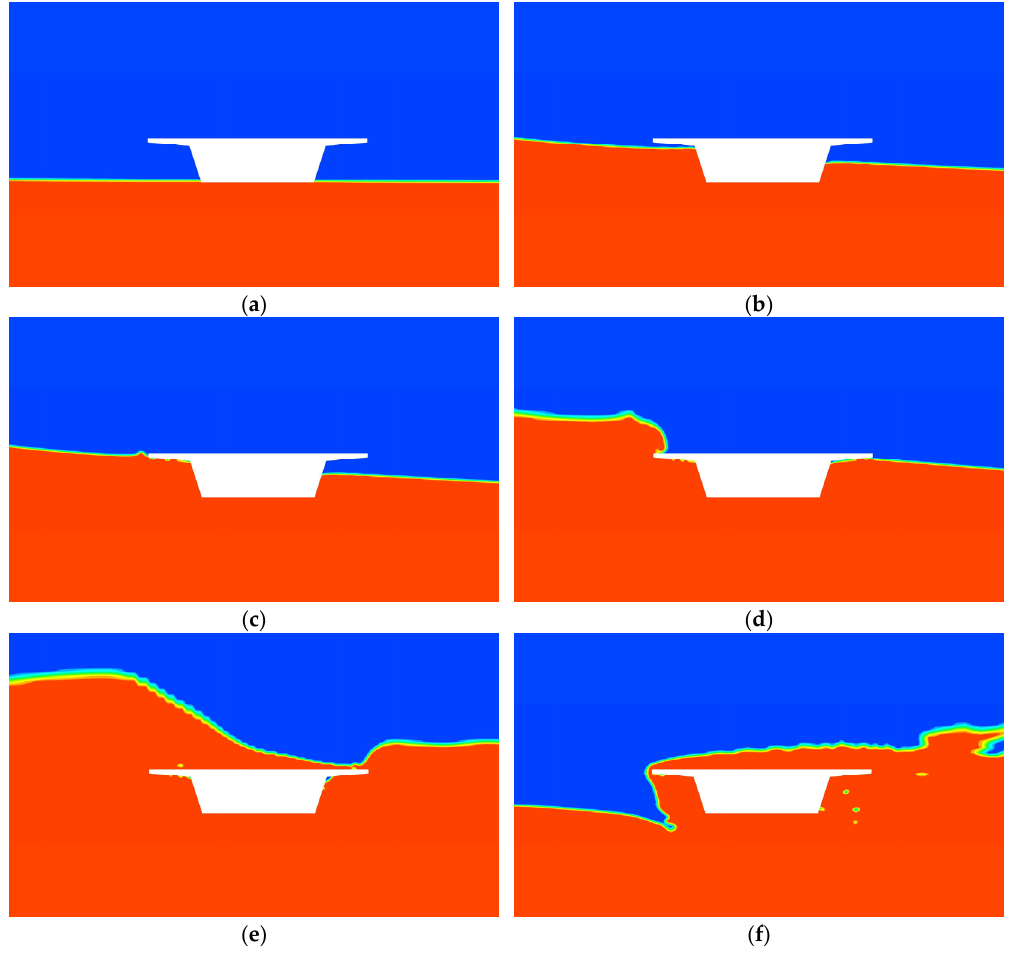
Figure 21. Snapshots in the bridge deck–wave interaction for K = 1628 of the Case E20/Cs (0). ( a ) 14.40 s; ( b ) 18.24 s; ( c ) 18.48 s; ( d ) 19.32 s; ( e ) 21.00 s; ( f ) 24.36